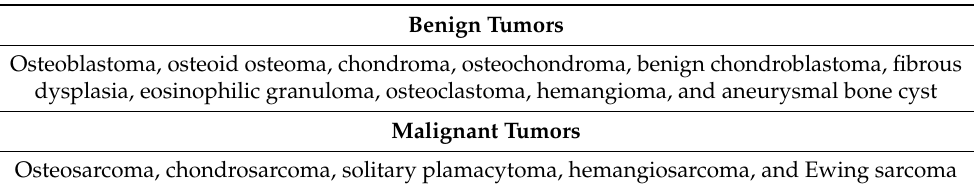
Table 1. Classification of primary osseous chest-wall tumors.